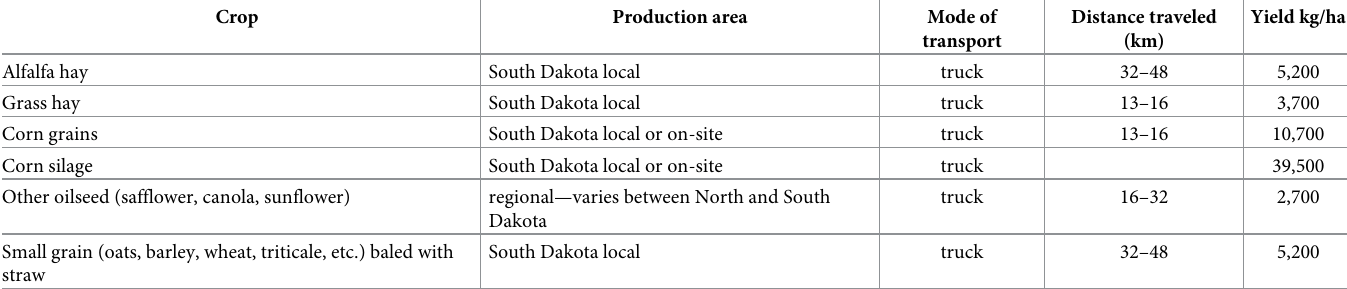
Table 2. Crop production area, transportation mode, distance traveled and yield.